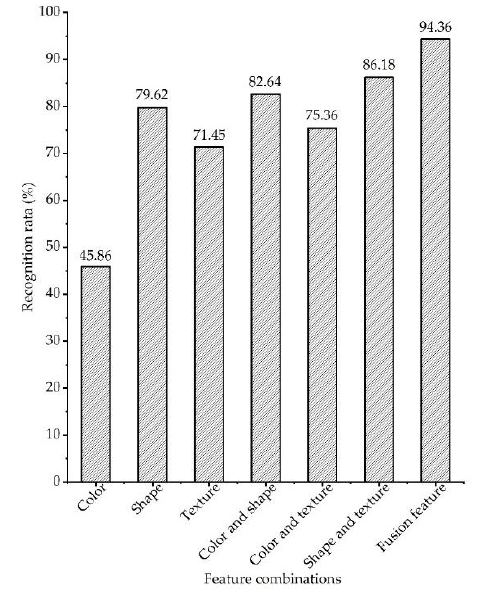
Figure 6. Classification results for different feature combinations under the SVM model.